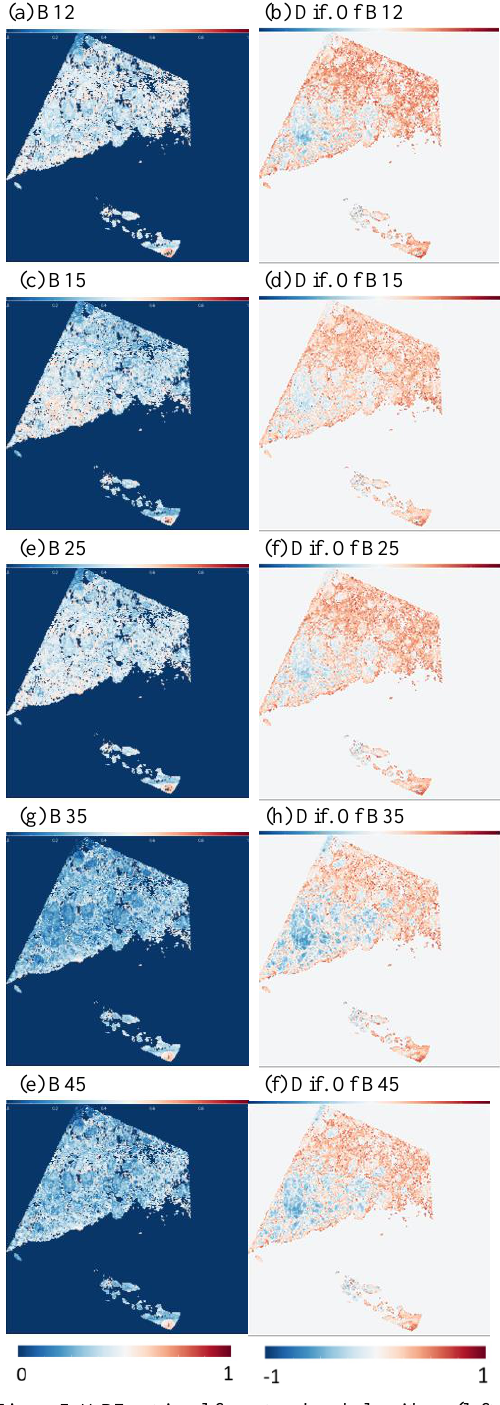
Figure 5. MPF retrieval from two-band algorithms (left panels) and the difference compared with that of Landsat discrimination (right panels)